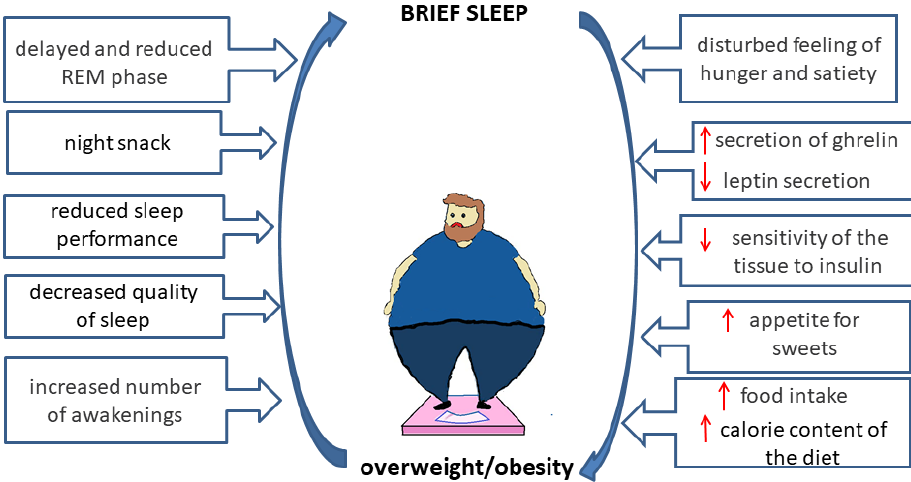
Figure 1. The relationship between inadequate sleep duration and calorie intake.